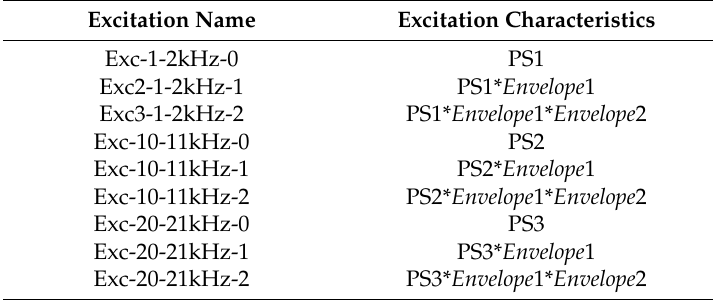
Table 1. Excitation patterns applied to the disk using the PZT (piezoelectric patch).